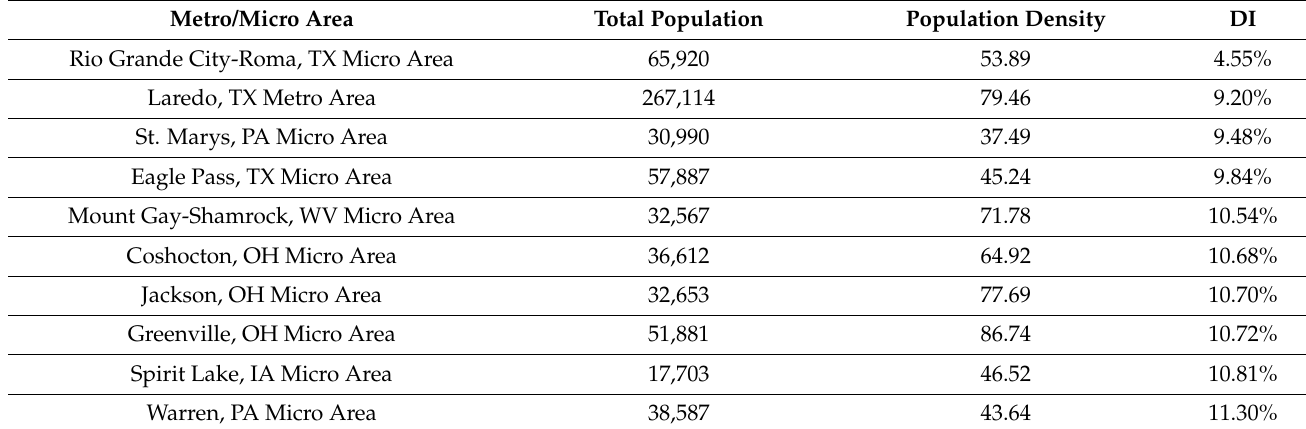
Table 2. Diversity Indexes: Ten Lowest Metro/Micro Areas,